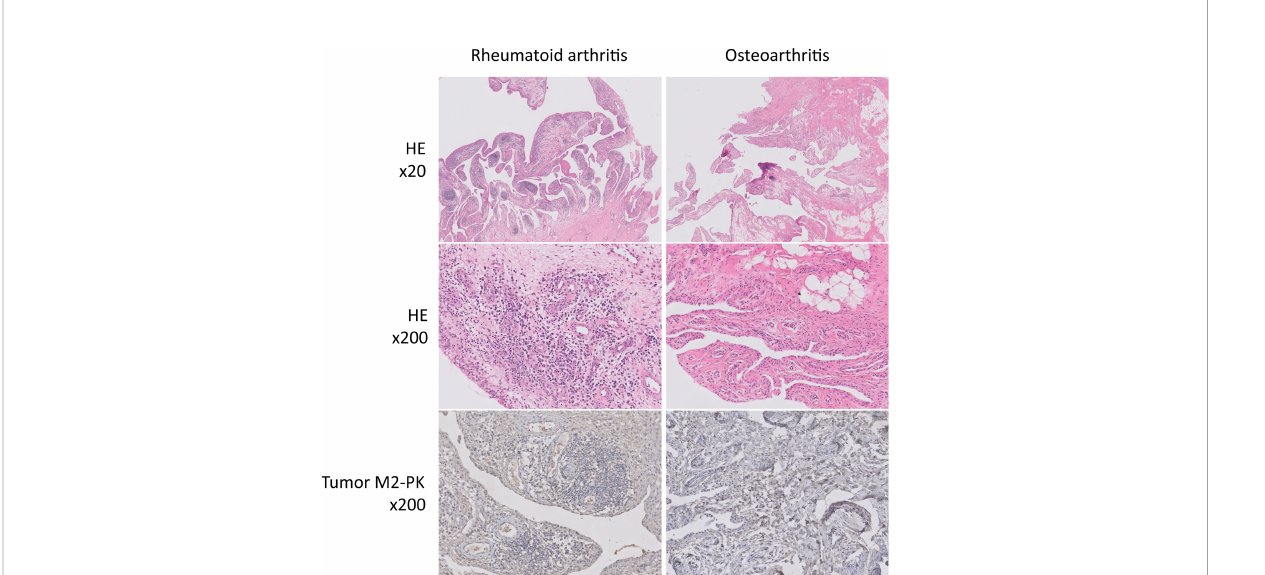
FIGURE 8 Immunohistochemical analysis of tumour M2-PK in knee synovial tissues of patients with RA and OA. In haematoxylin and eosin-stained synovial tissue from patients with RA, dense in fi ltration of plasma cells, lymphocytes, and macrophages; germinal centre formation; and villous synovial hyperplasia and hypertrophy were observed. In contrast, the OA synovium showed fatty ingrowth and synovial hyperplasia with myxoid degeneration. Tumour M2-PK immunohistochemical staining in synovial tissues from patients with RA and OA showed no de fi nite expression of local tumour M2-PK. Tumour M2-PK: dimeric form of pyruvate kinase M2; RA, rheumatoid arthritis; OA,